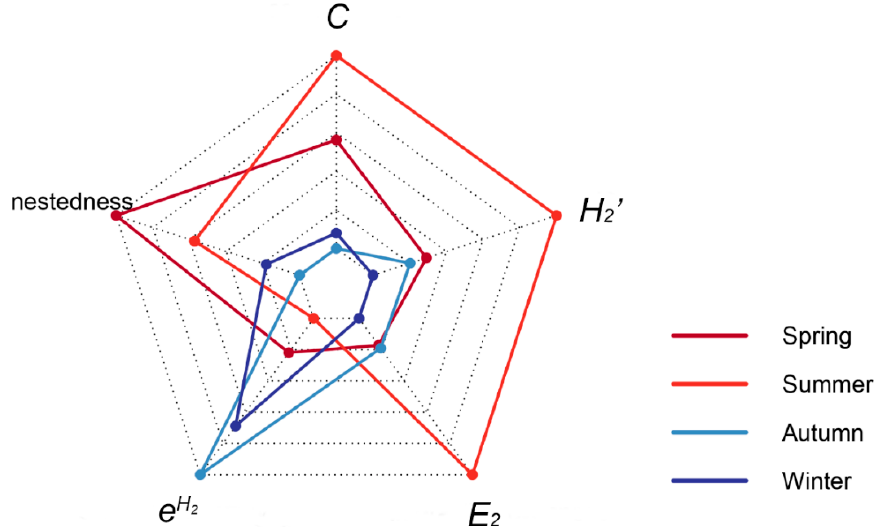
Figure 3. Characteristics of plant – frugivore networks in different seasons.